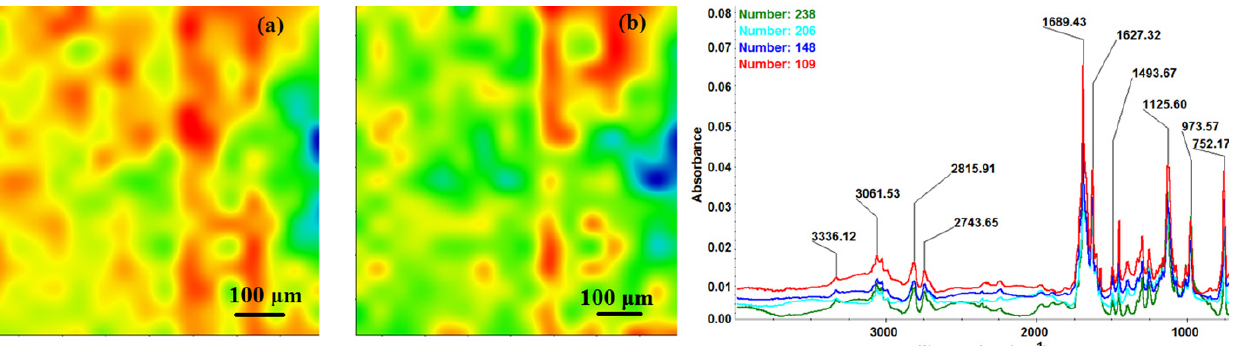
Figure 4. Second derivate IR mappings and IR spectra of thin coating (F = 400 mJ/cm 2 ) surface: intensity distribution of ( a ) 2815 cm